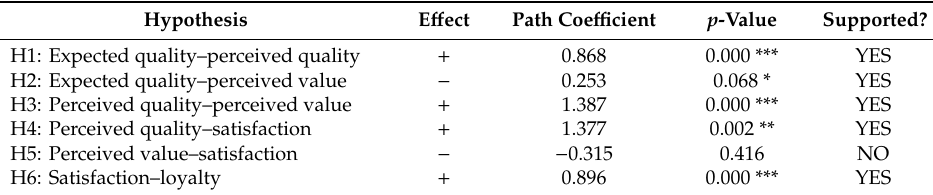
Table 9. Hypothesis testing.